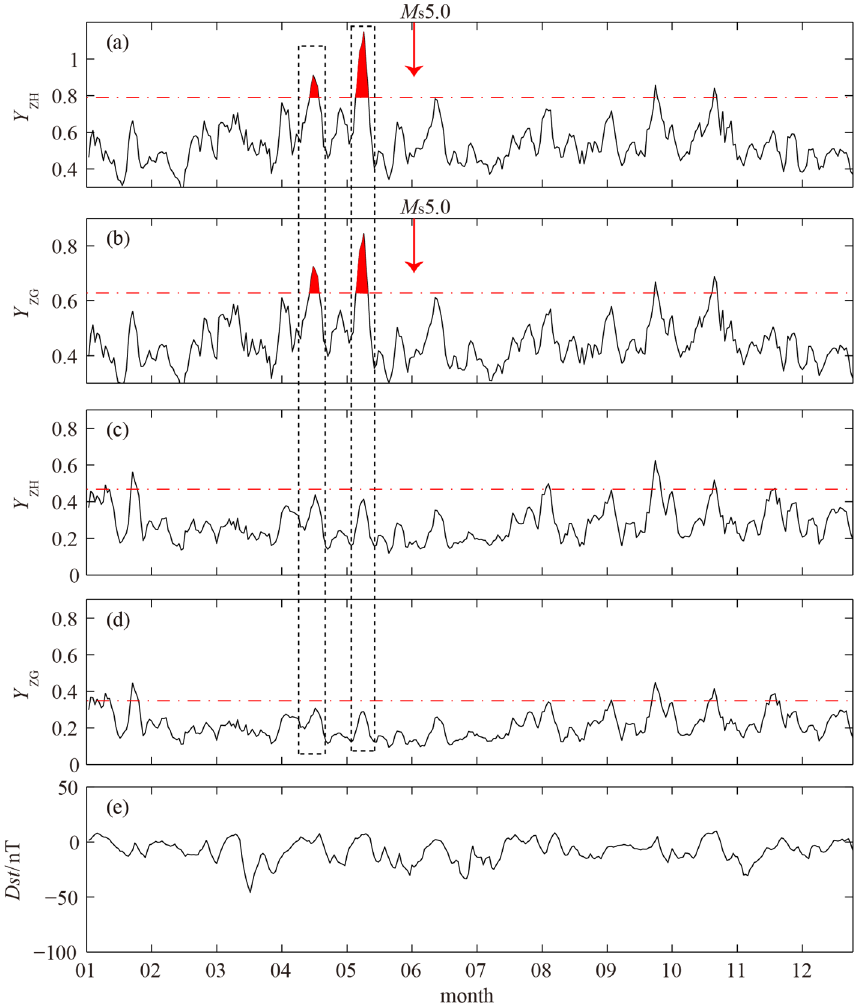
Figure 3. Polarization ratios of Y ZH at ( a ) GLM, ( c ) CNH stations and Y ZG at ( b ) GLM, ( d ) CNH observatories about 0.1 Hz during 2013 and ( e ) Dst index.